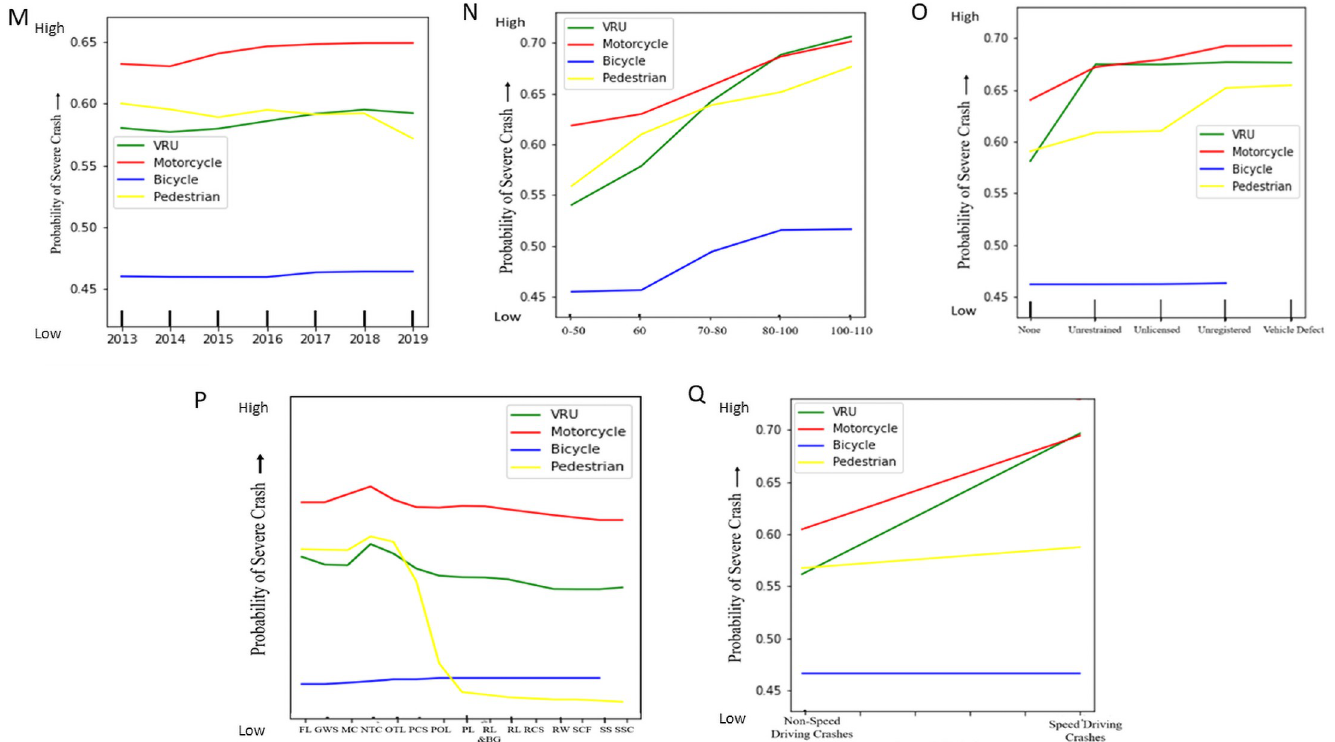
Fig 7. Partial dependency plots of different features with respect to VRU crash severity. (M) Year (N) Speed Limit (O) Vehicle Condition (P) Traffic Control (Q) Speed Driving.